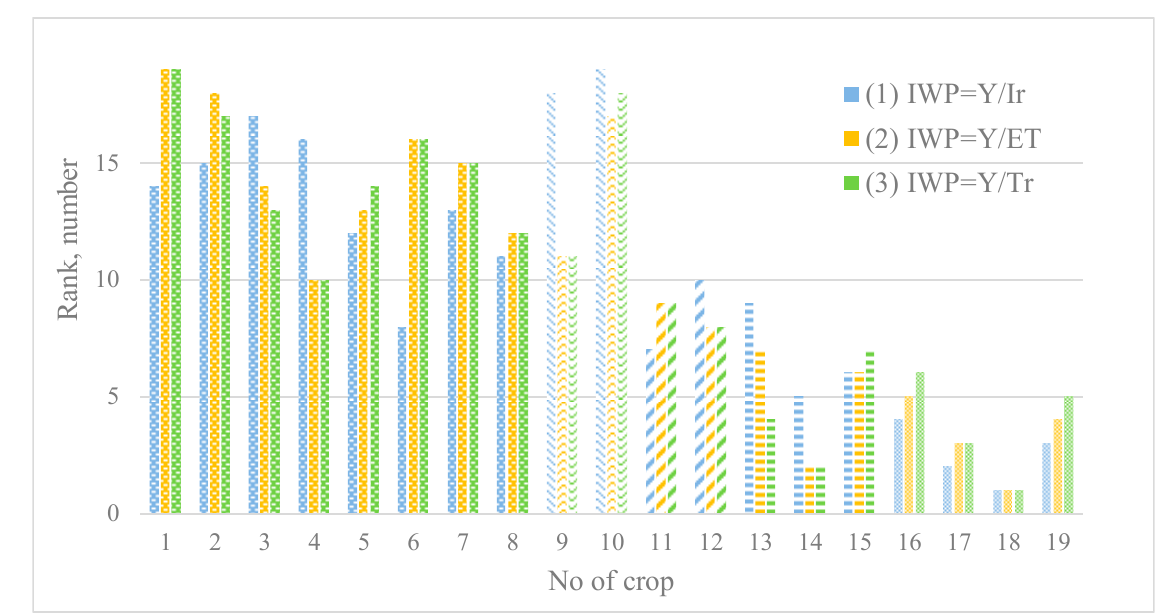
Figure 6. Results of ranking 19 crops of irrigated alfalfa in terms of water productivity (1)–(3).